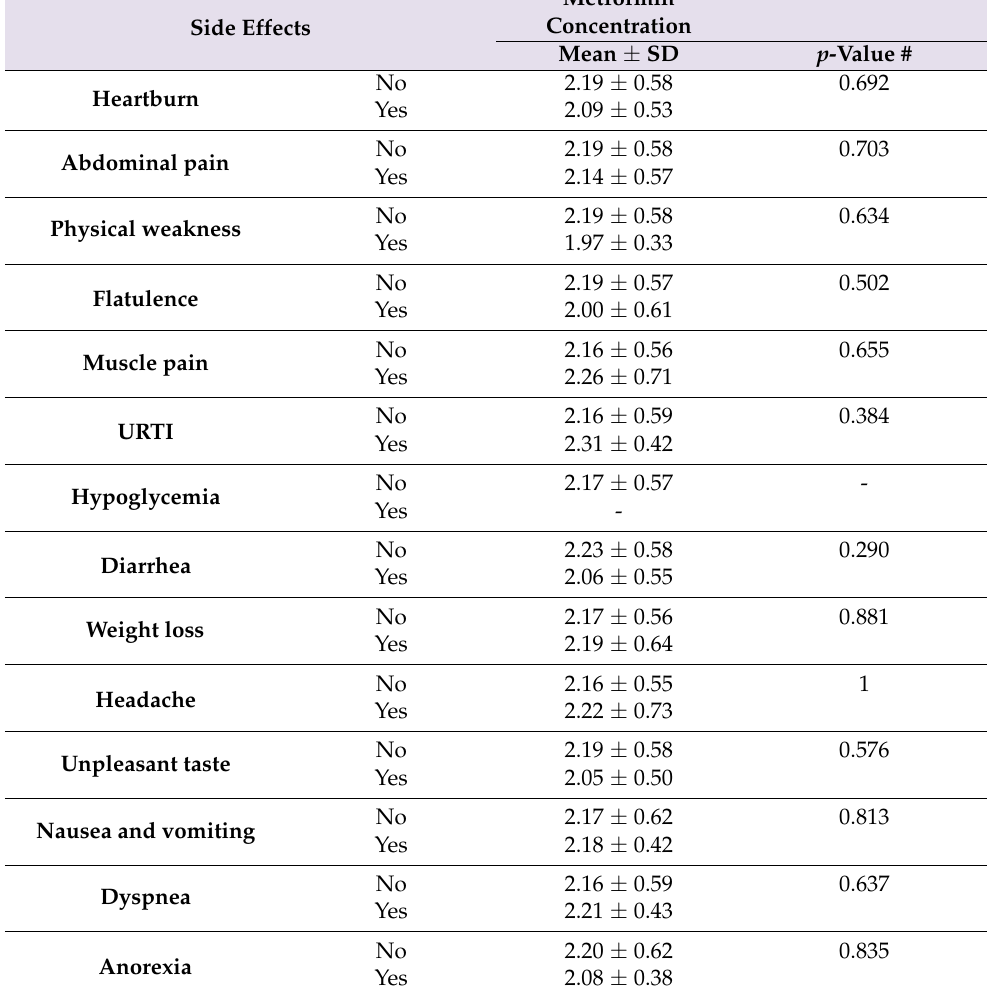
Table 6. The concentration of metformin according to the occurrence of its side effects (n = 51).